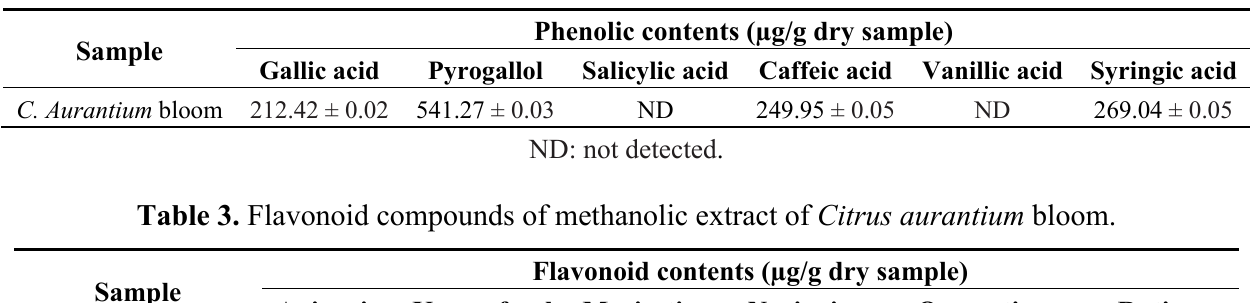
Table 2. Phenolic compounds of methanolic extract of Citrus aurantium bloom.